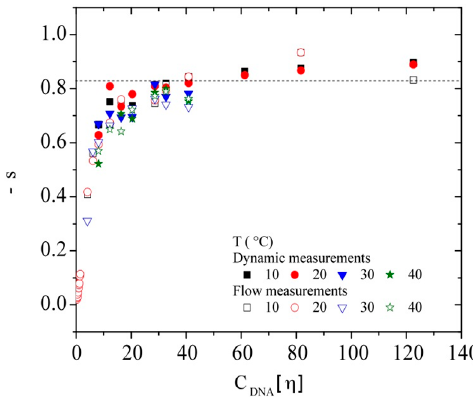
Figure 13. Slope − s in the power law region determined on flow curves of calf-thymus DNA in TE Figure 13. Slope ´ s in the power law region determined on flow curves of calf-thymus DNA in TE buffer at the temperatures of 10, 20, 30, and 40 °C. The values obtained by Cox Merz analysis are also buffer at the temperatures of 10, 20, 30, and 40 ˝ C. The values obtained by Cox Merz analysis are also represented. (Dashed line represents the limit proposed by Graessley [63]). represented. (Dashed line represents the limit proposed by Graessley